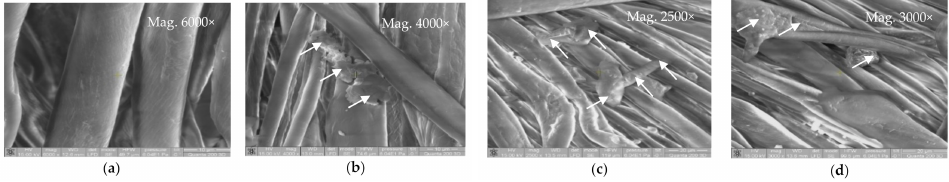
Figure 5. Morphologic aspect of some samples: ( a ) control sample; ( b ) S5 treated sample; ( c ) S14 treated sample; ( d ) S15 treated sample (same codes as in Table